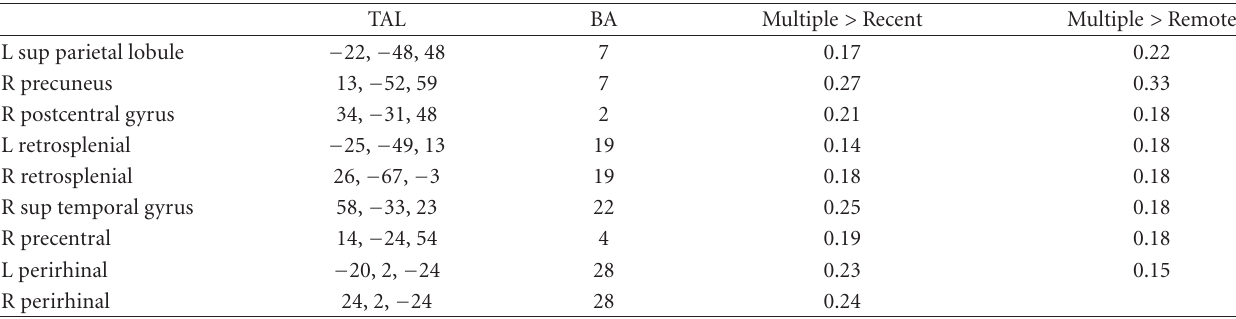
Table 6: Mean e ff ect sizes (standard error of the mean) for the direct comparisons of multiple > recent and multiple > remote ( P < .01) after matching RTs. Noted are Talairach coordinates (TAL) and Brodmann’s areas (BAs) referencing the center of the activation cluster (superior, sup).